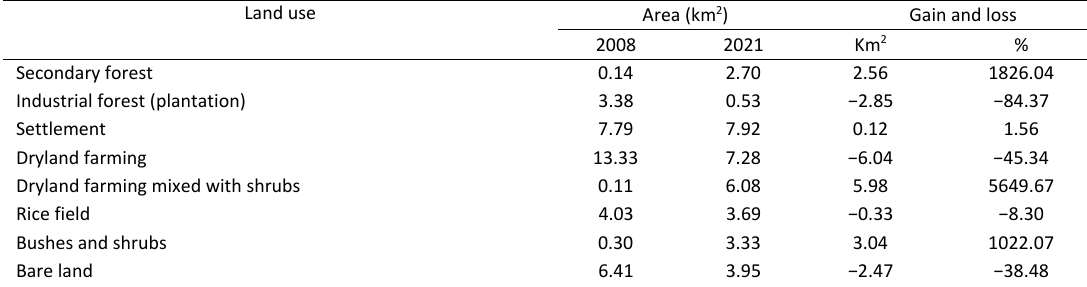
Table 4: Land use in 2008 and 2021